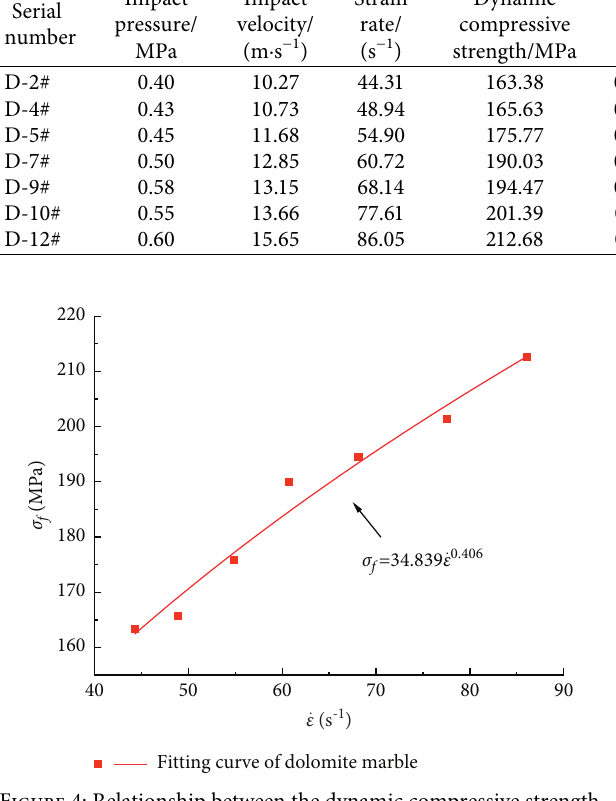
Figure 4: Relationship between the dynamic compressive strength and strain rate of dolomite marble.